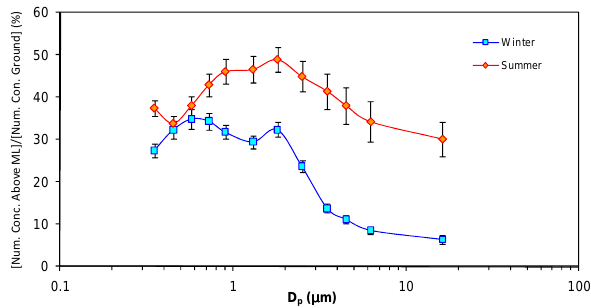
Fig. 6. Percentage of the number-concentration measured above the ML, over that measured at ground-level, as a function of aerosol size. Data were collected in the winter (DJF months; N pro- files=142) and in the summer (JJA months; N profiles=72).